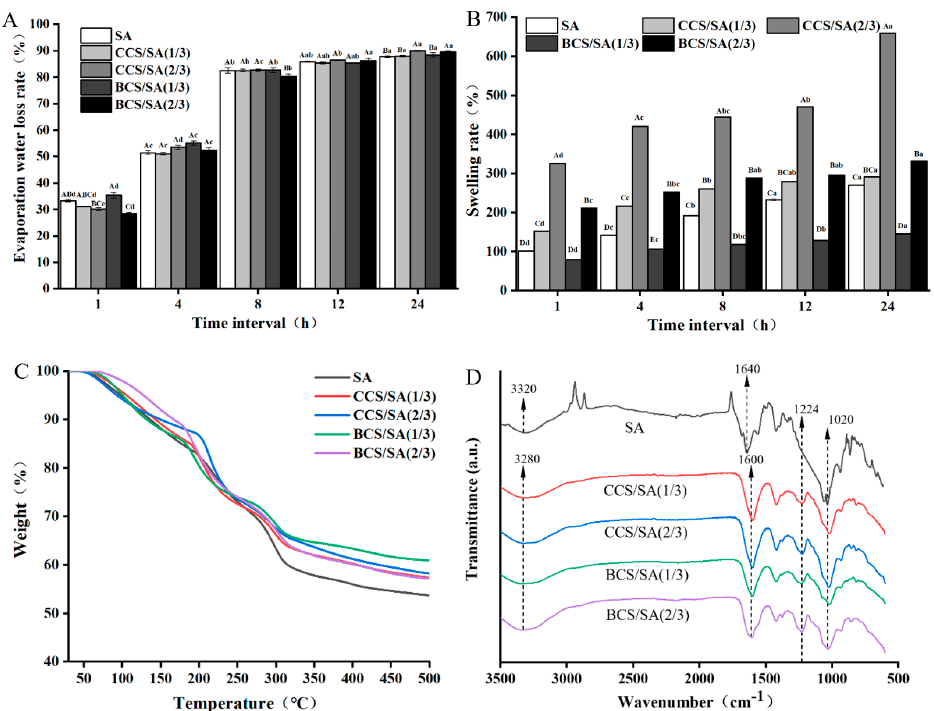
Figure 2. ( A ) Evaporation loss rate profiles, ( B ) swelling rate profiles, ( C ) TGA curves, and ( D ) FTIR spectra of the SA, CCS/SA (1/3), CCS/SA (2/3), BCS/SA (1/3), and BCS/SA (2/3) hydrogels. Different uppercase letters (A–E) indicate significant differences between hydrogels within the same time interval ( p < 0.05), and different lowercase letters (a–e) indicate significant differences for the same hydrogel over different time intervals ( p < 0.05).